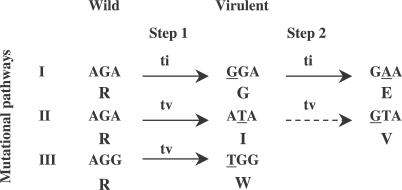
Mutational Pathways to Virulence within Codon 48 of the VPgMutational pathway I was shared by all strains with the notable exception of strain S2/S3. It involved two successive transitions (ti) from the wild arginine coded by codon AGA. Mutational pathway II was isolate-specific (CI4) and involved two successive transversions (tv). The dotted arrow indicates that V48 arose but did not replace I48. Mutational pathway III was specific for isolate Ma203 of the S2/S3 strain, with the wild arginine coded by codon AGG. It involved a single transversion.